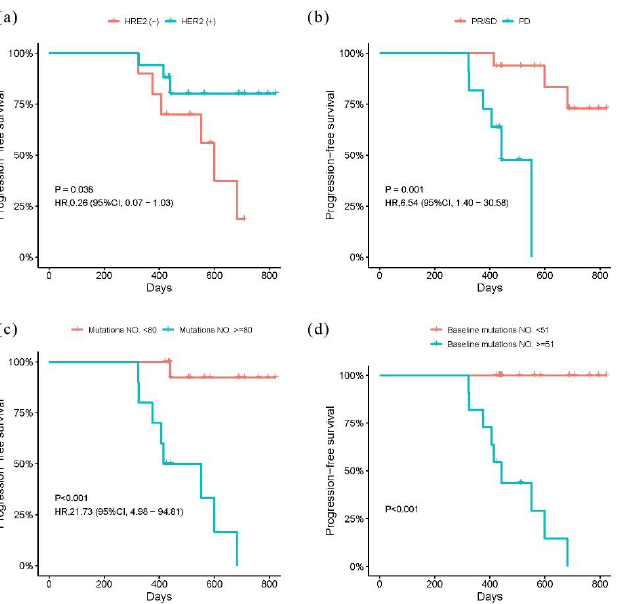
Figure 4. Kaplan–Meier estimate of PFS. ( a ) Kaplan–Meier curves for HER2 status. ( b ) Kaplan–Meier curves for therapeutic effect. ( c ) Kaplan–Meier curves for mutations in overall ctDNA. ( d ) Kaplan– Meier curves for mutations in baseline ctDNA.